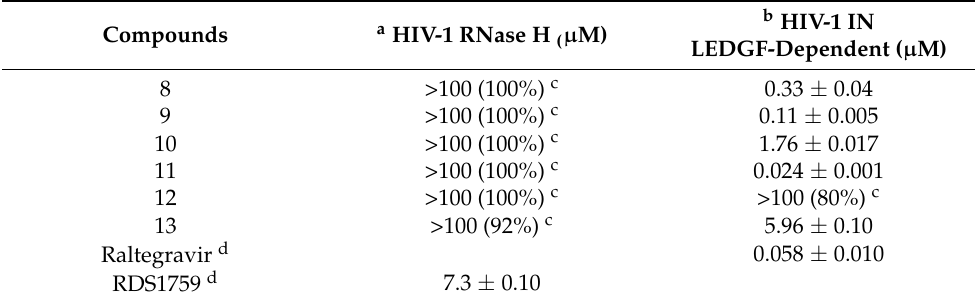
Table 4. Anti-HIV activity of pure compounds isolated from fraction